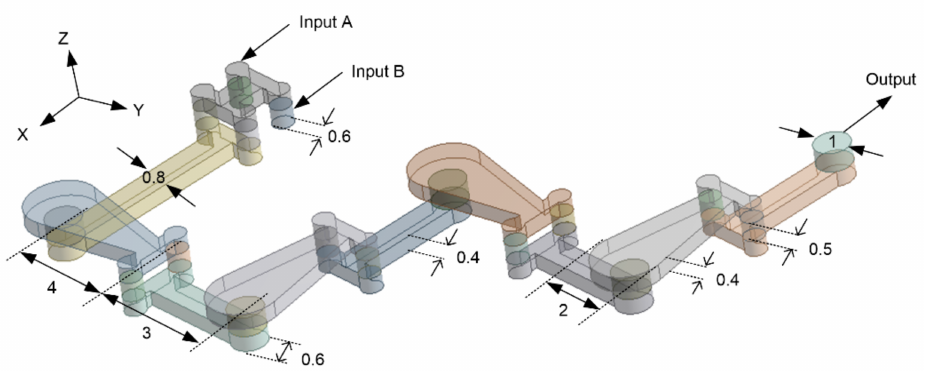
Figure 3. Diagram of ‘ H − C ’ micromixer (all the dimensions are in